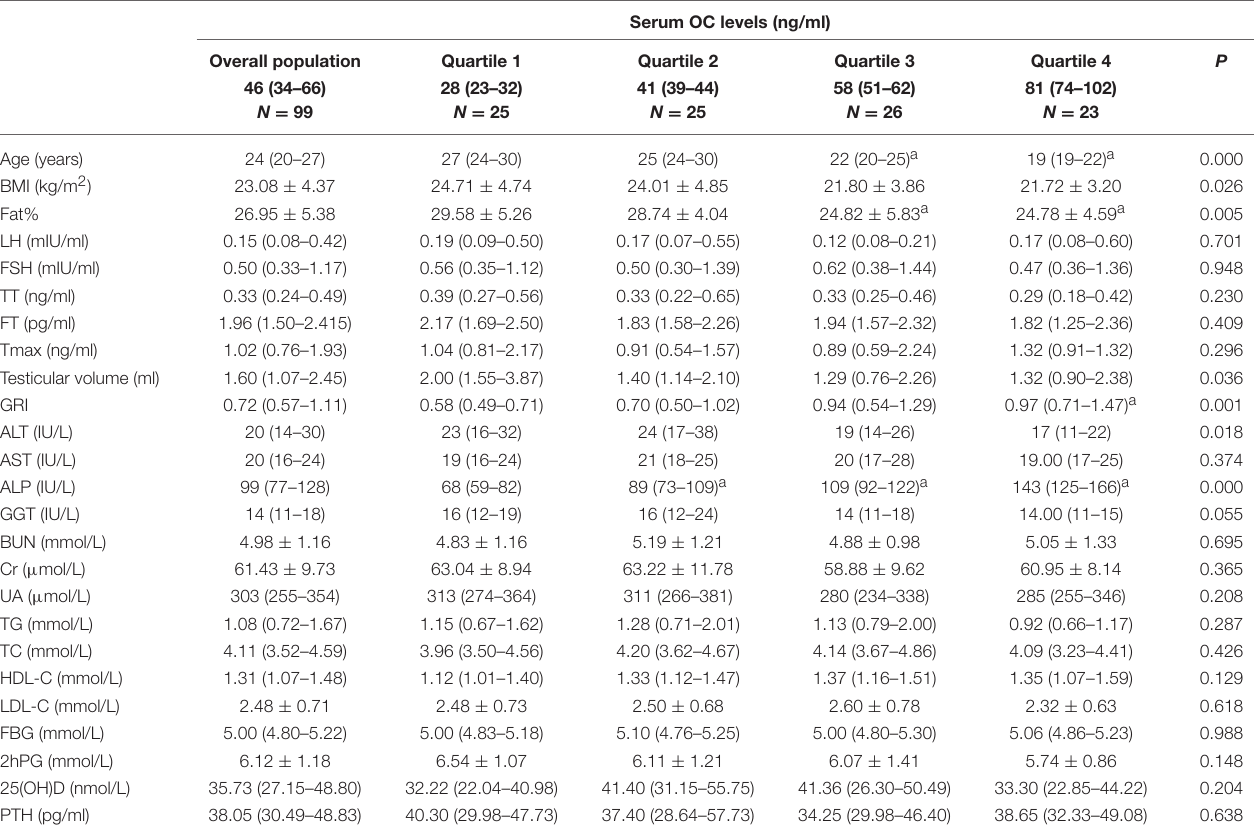
TABLE 1 | Baseline clinical characteristics of IHH patients by quartiles of serum OC levels.